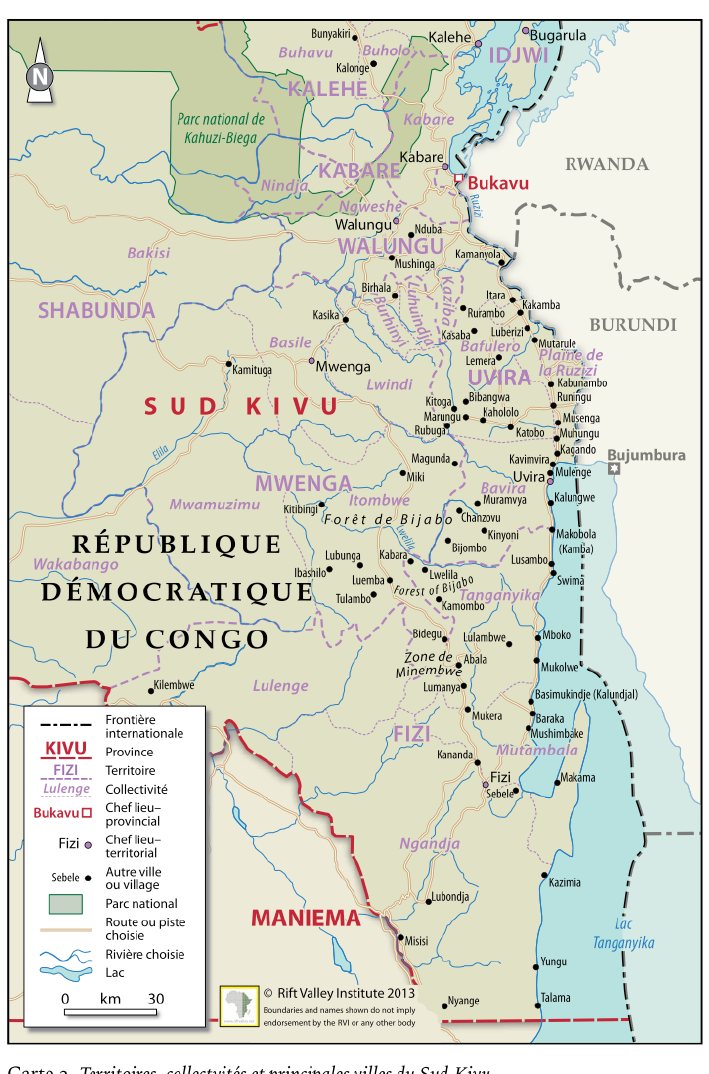
Figure 0B: A map of South-Kivu Province Showing the territories (Kabare, Walungu, Kalehe) where study sites were selected across the different sweet potato growing